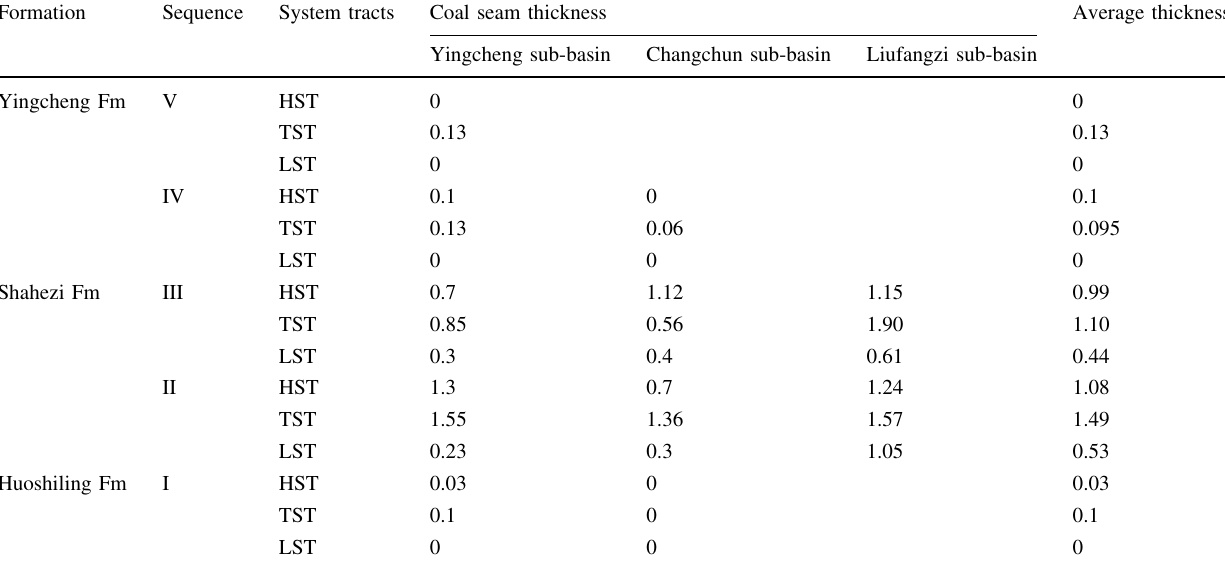
Table 1 Distribution of coal seams in the Early Cretaceous sequence stratigraphic framework of Songliao Basin